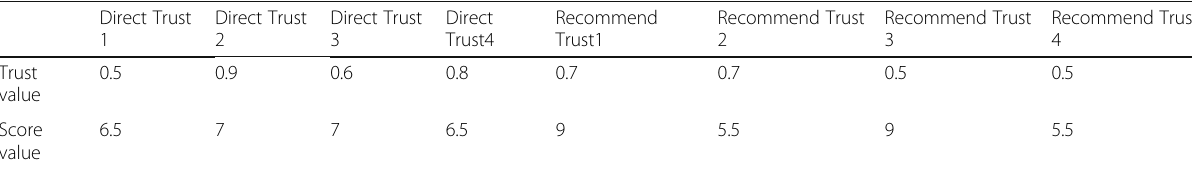
Table 2 Trust value and score value Direct Trust